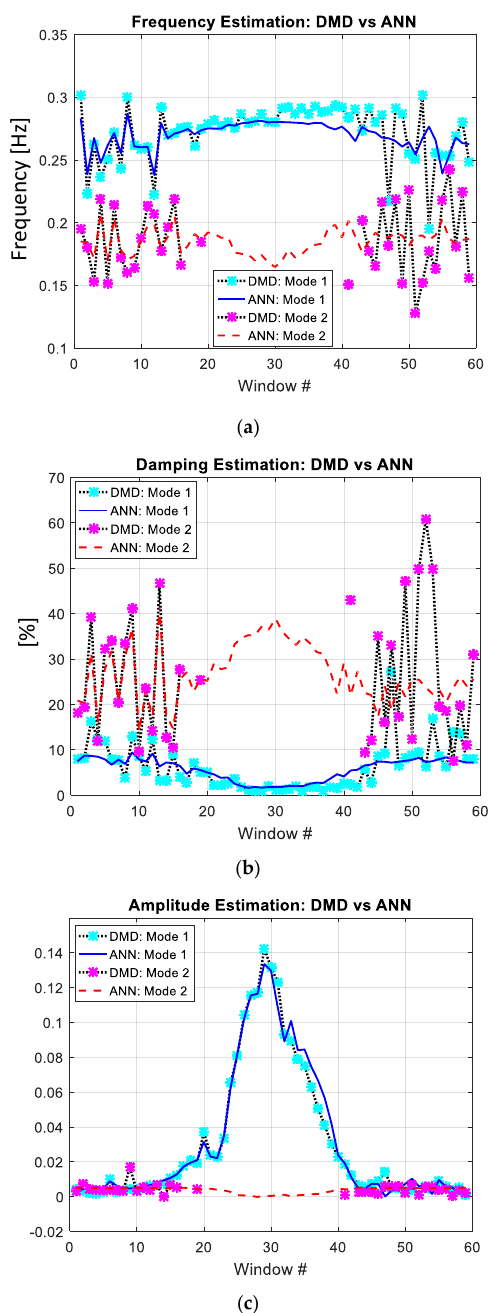
Figure 6. Comparison of the estimates produced by DMD versus the estimates produced by the ANN approach for the case of Dataset DS2: ( a ) frequency; ( b ) damping, ( c ) amplitude.